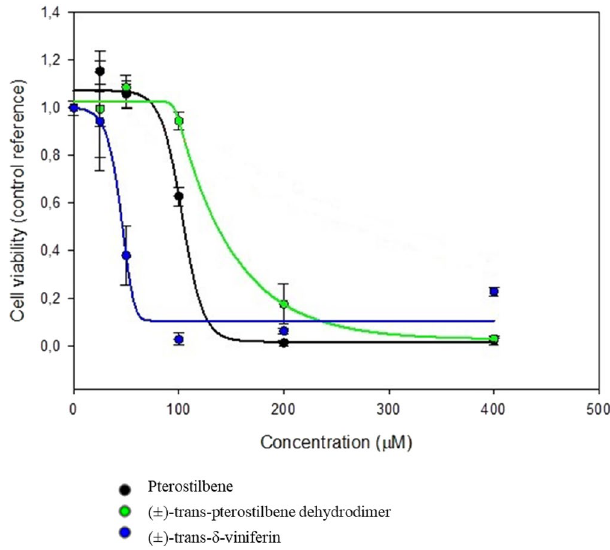
Figure 9. Caco-2 cell lines IC 50 curve for stilbenoids after 24 h of stimulation.